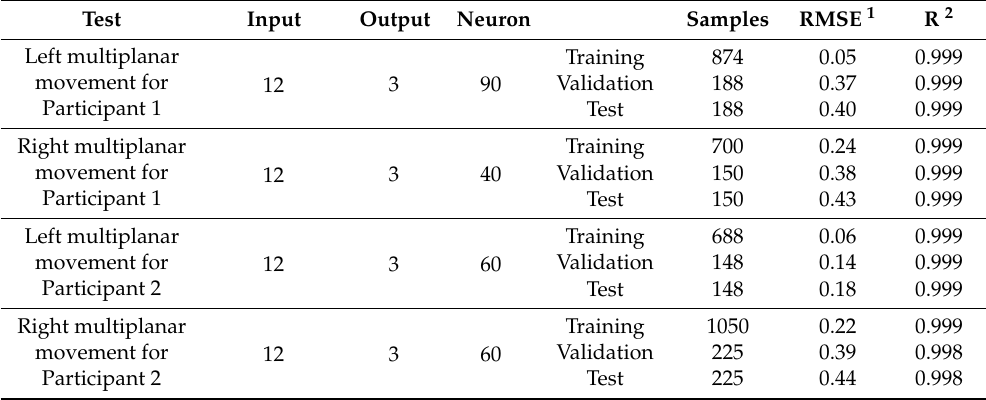
Table 3. The results of network training for the multiplanar movements performed by each participant. The outcome of network training for planar movements .